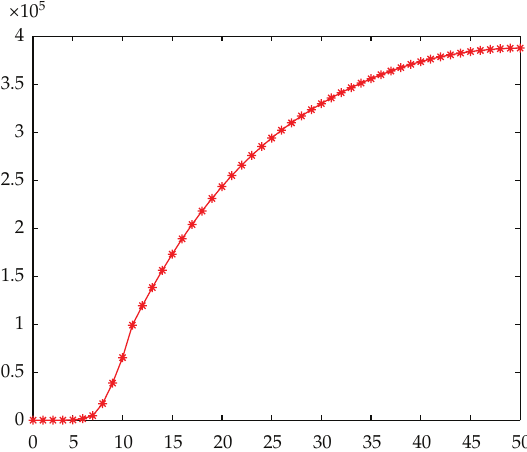
Figure 5: Virus population before optimal